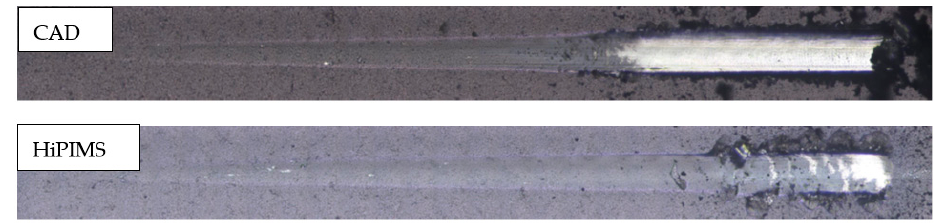
Figure 6. Adhesion of the studied coatings to the carbide substrate.